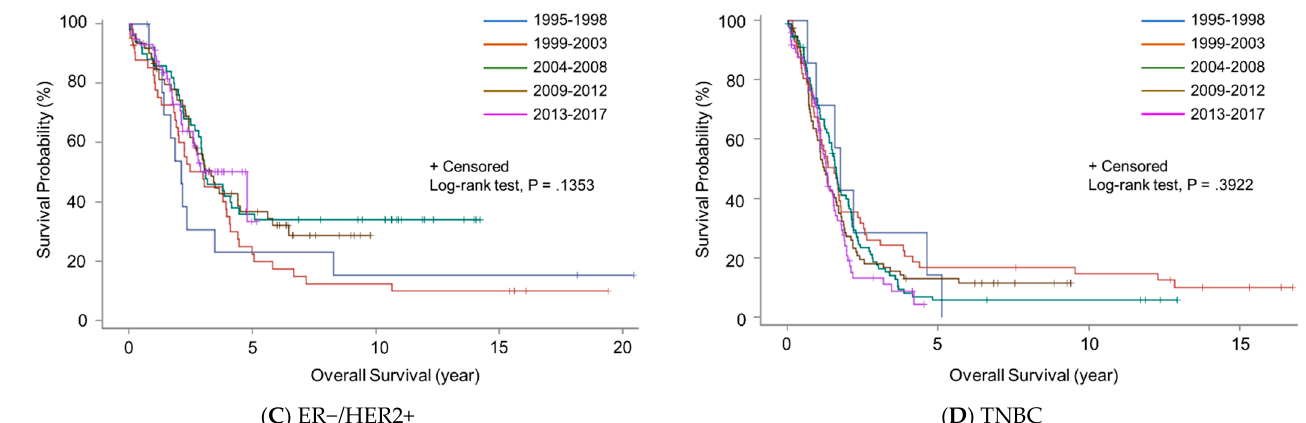
Figure 3. Overall survival curves for patients with de novo metastatic breast cancer according to year of diagnosis and breast cancer subtype: ( A ) estrogen receptor positive and HER2 negative (ER+/HER2 − ); ( B ) ER+/HER2 positive (HER2+); ( C ) ER-negative/HER2+; ( D ) triple-negative breast cancer.